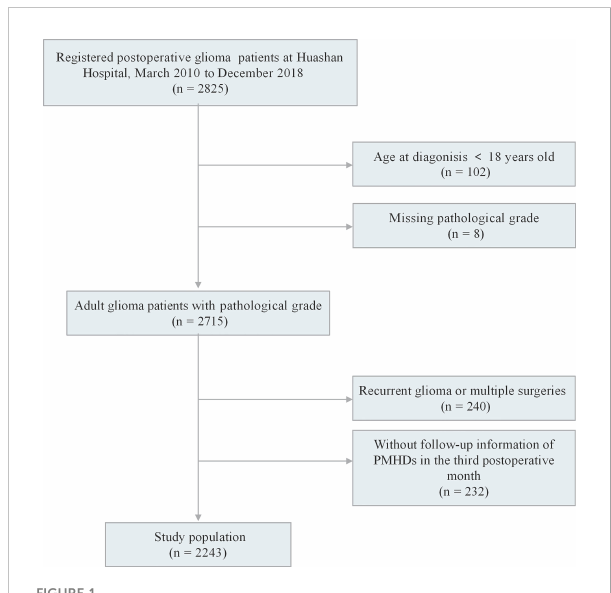
FIGURE 1 Details of study recruitment. PMHDs, postoperative mental health